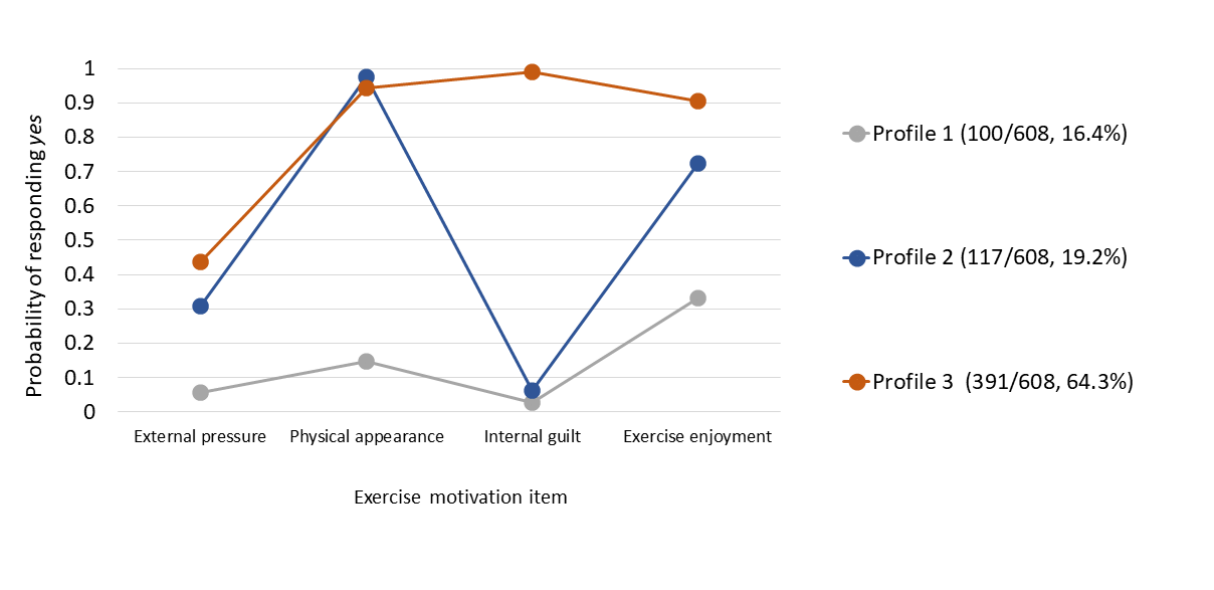
Figure 1. Latent class analysis of motivation profiles (N=608), adjusting for age.